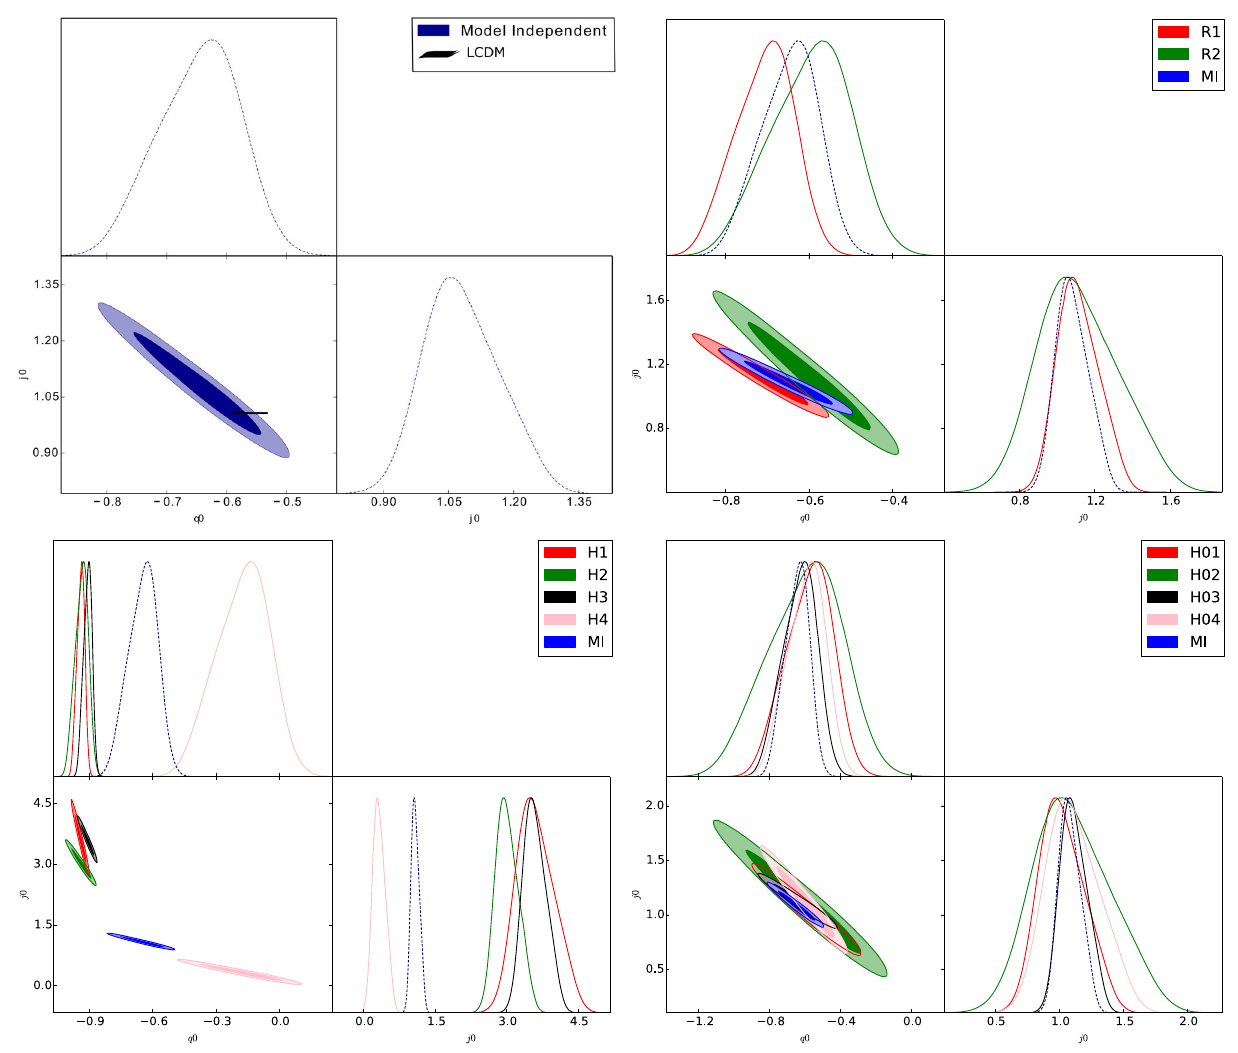
Fig. 3 The results of q 0 − j 0 space up to 2 − σ confidence level obtained for different types of DE models compared with model inde- pendent results. The concordance model (top-left panel), RVMs (top-